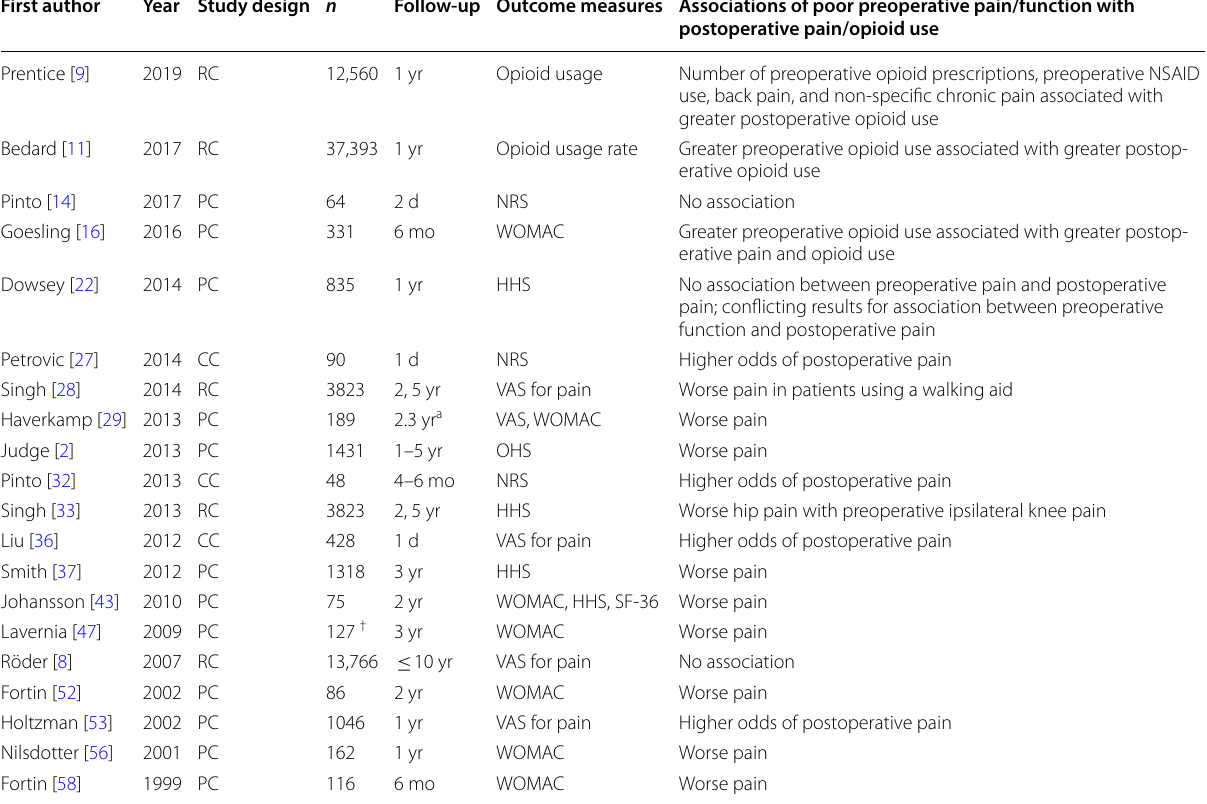
Table 3 Associations of preoperative pain medication or opioid use and function with pain medication or opioid use after